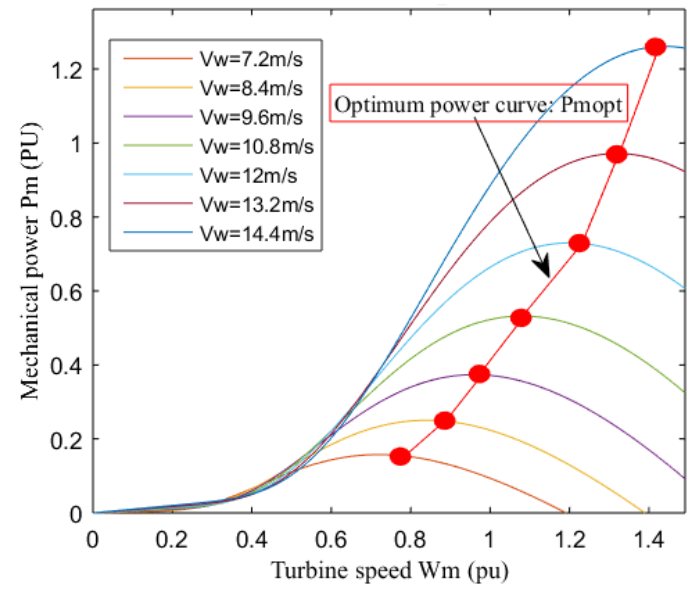
Figure 4. Turbine Power Characteristics (Pitch angle beta =